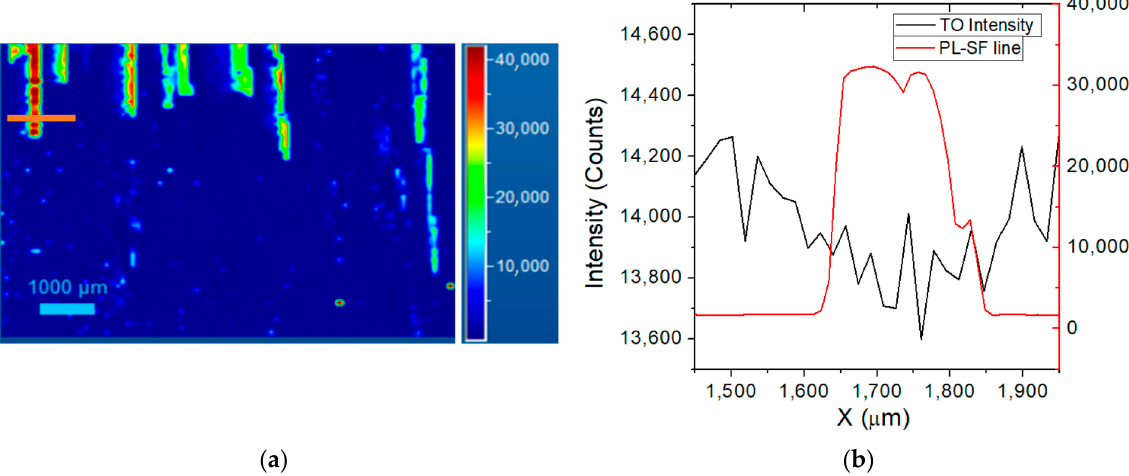
Figure 6. PL map of an isolated defective zone (SF at 430 nm) ( a ), and the result of the Raman map line compared with the TO intensity variation ( b ), using a laser power of 15 mW.